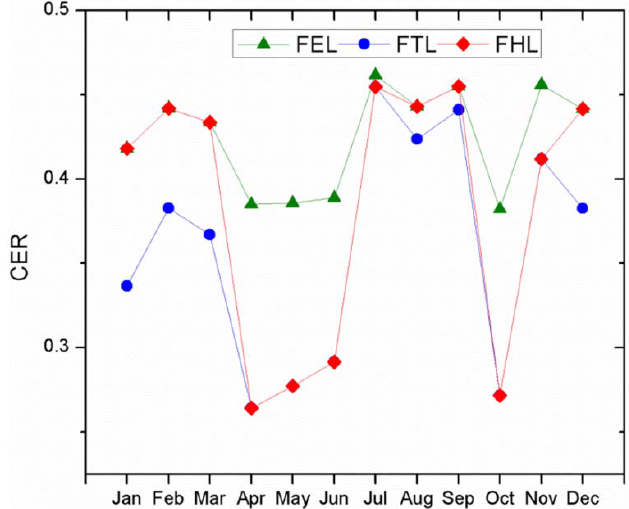
Figure 11. The CER variations of CCHP system in FEL, FTL, and FHL mode based on simulated data.